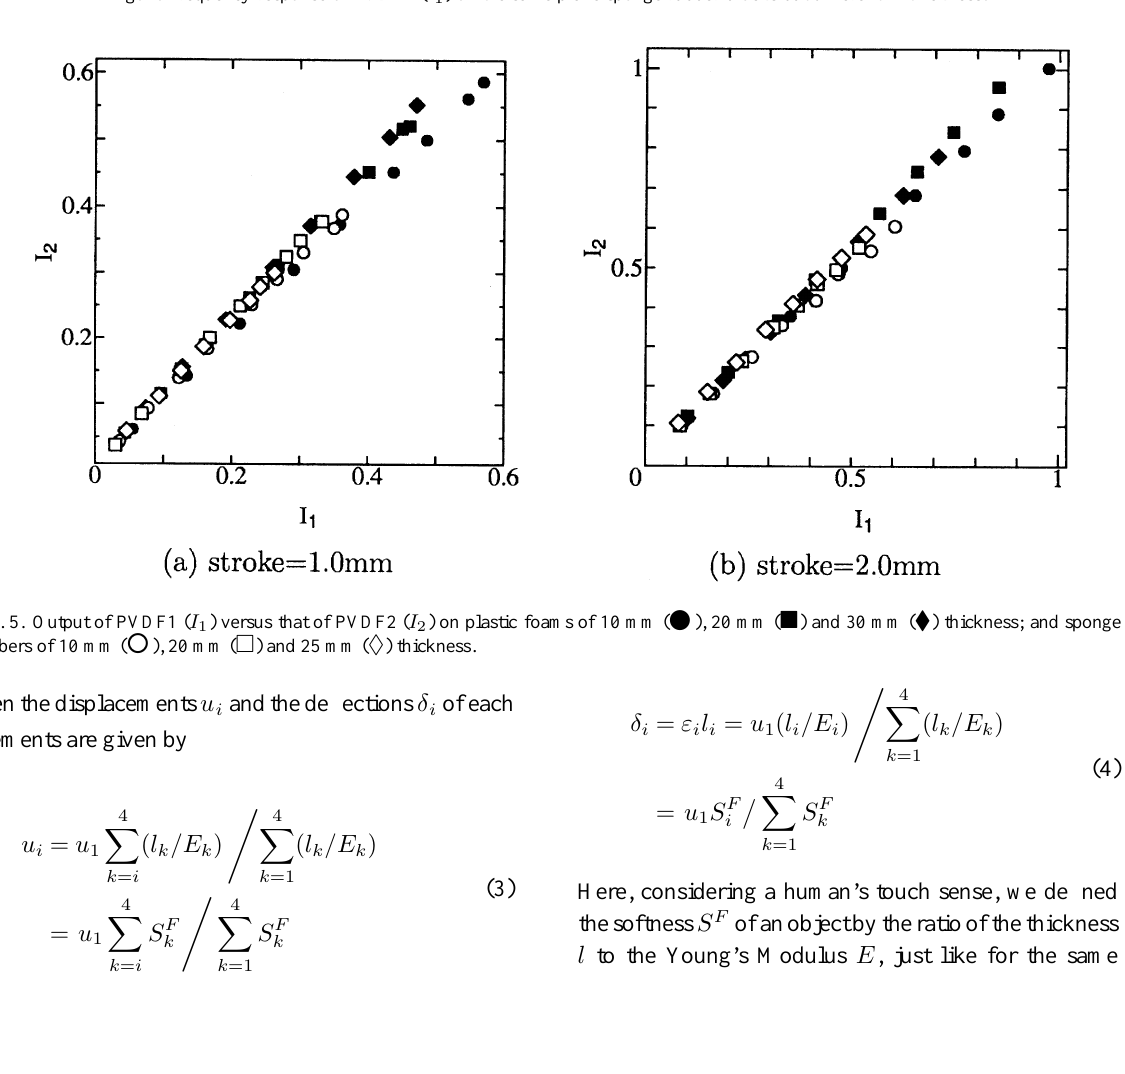
Fig. 4. Frequency response of PVDF1 ( I 1 ) on the same plane sponge rubber blocks but different in thickness.